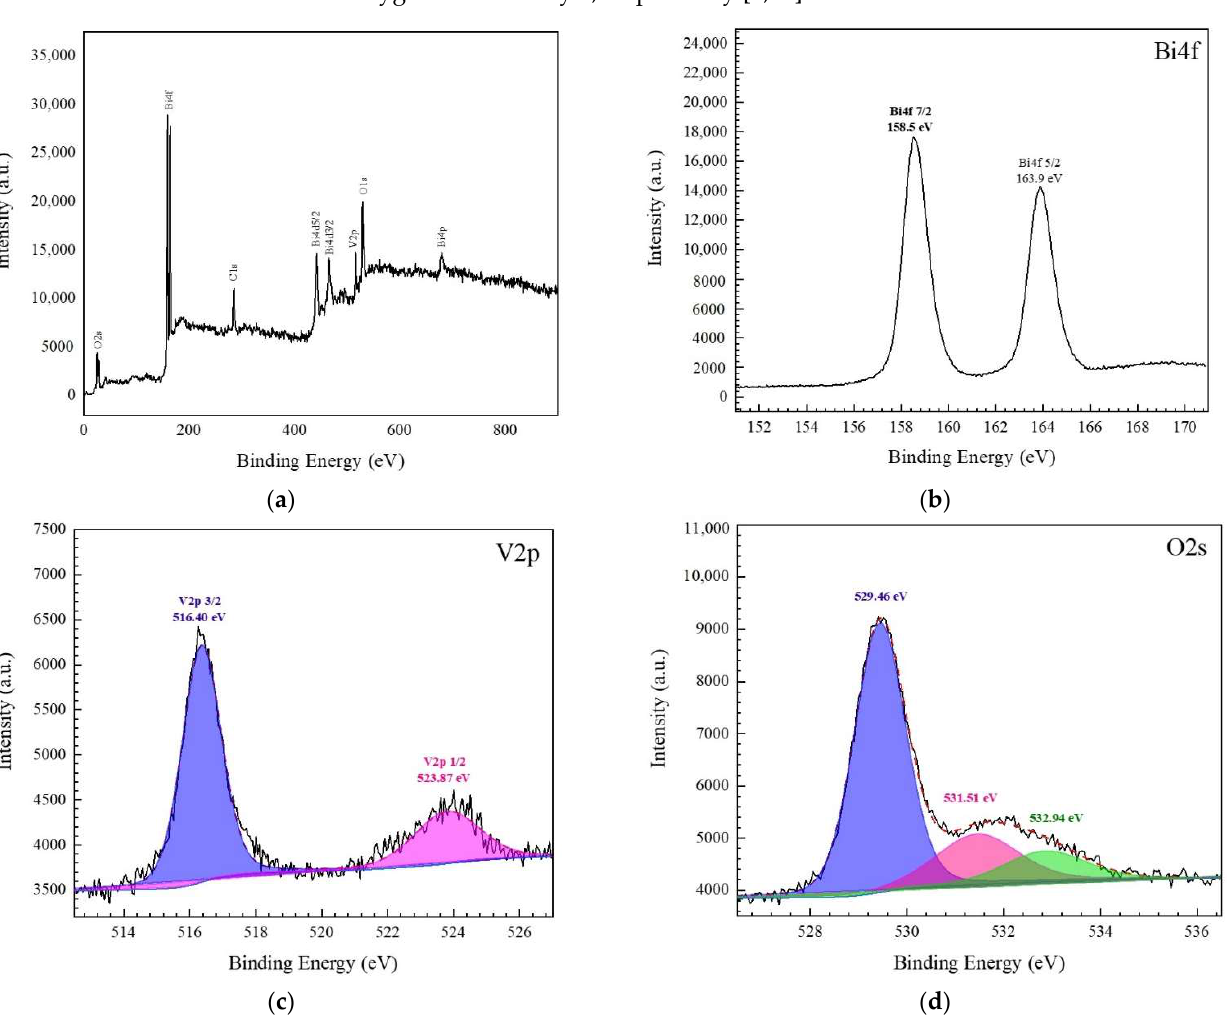
Figure 4. XPS survey scan ( a ), core level spectra of Bi 4f ( b ), V 2p ( c ), and O 1s ( d ) of the prepared BiVO 4 catalyst.